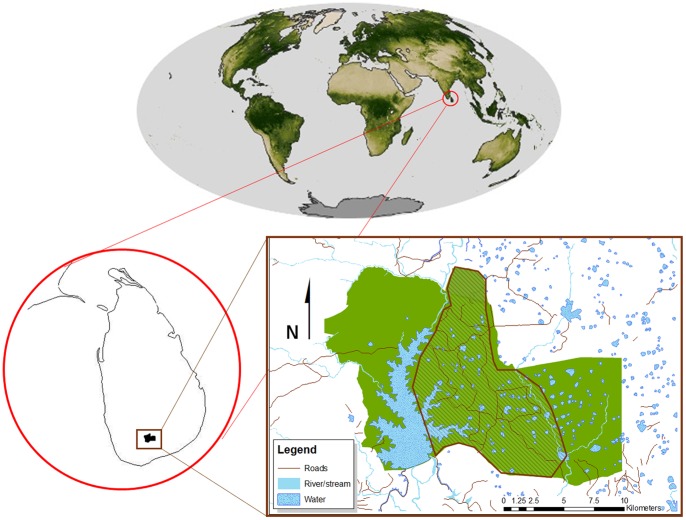
Uda Walawe National Park.The study was conducted along the road network in the middle portion of the park, represented by the hashed lines (<100 Km2). Images sources: NASA Earth Observatory (http://earthobservatory.nasa.gov), the Department of Wildlife Conservation, Sri Lanka, and the Center for Conservation Research, Sri Lanka.